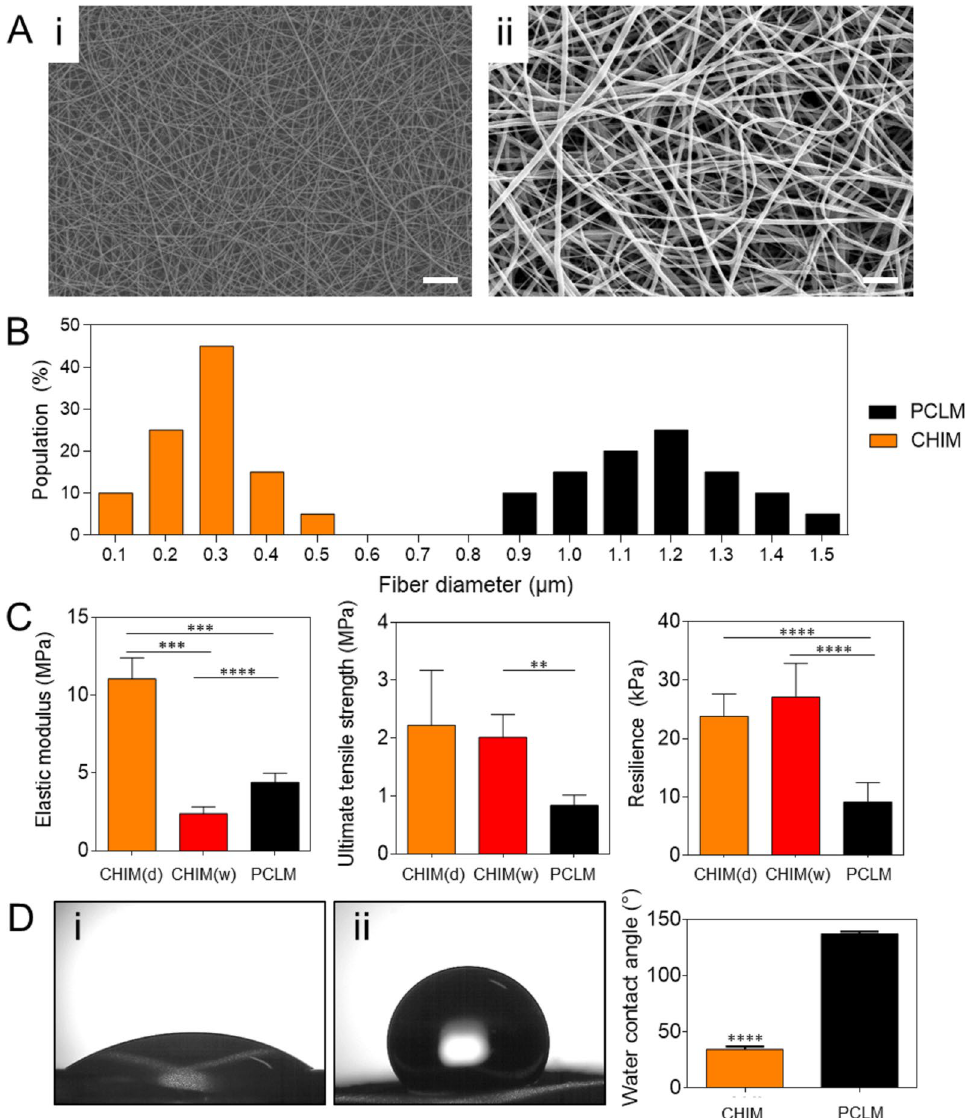
Figure 2. Characteristics of the chitosan-based nanofiber membrane (CHIM): ( A ) Scanning electron microscopy (SEM) images of the membranes at 1000 × magnification: (i) CHIM and (ii) Polycaprolactone (PCL)-based membrane (PCLM). Scale bars, 10 μm. ( B ) Distribution of fiber diameters based on the SEM images. ( C ) Mechanical properties of CHIM and PCLM in the dry and wet states. ( D ) Water contact angle of each membrane: (i) CHIM and (ii) PCLM. Each bar reflects the mean ± standard deviation. ** p < 0.01, *** p < 0.005, **** p <